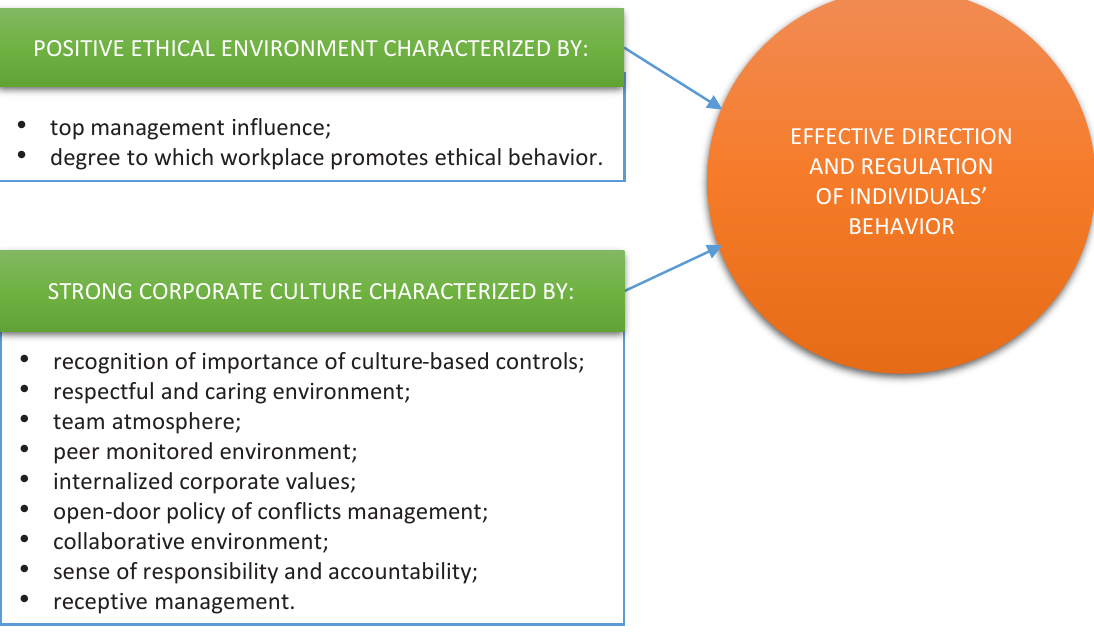
Figure 1. The causal relationship between dependent and independent